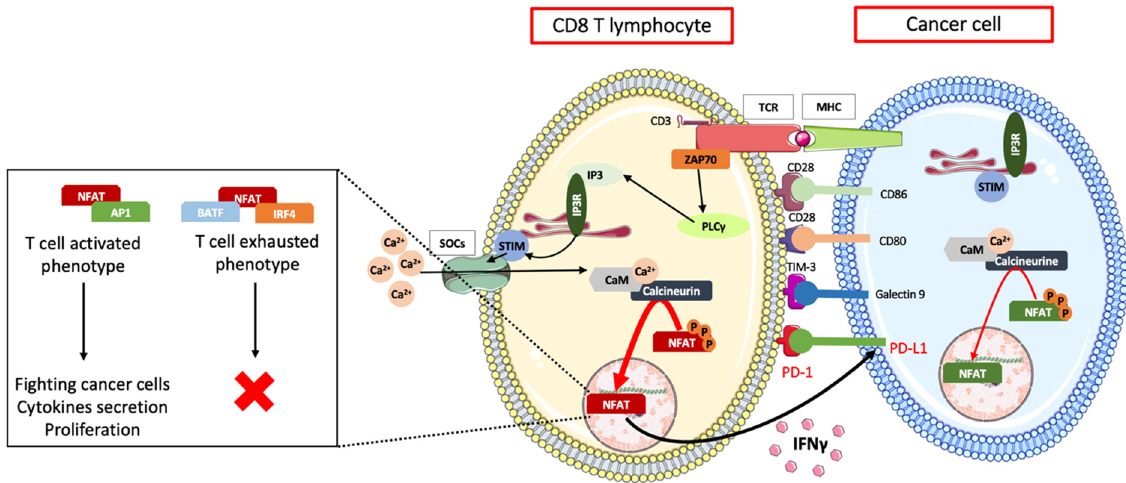
Figure 5. Cancer cell immune escape. The binding of the target cell’s MHC or antigen to the T lymphocyte TCR complex induces the release of ER calcium stores, leading to Stim1 oligomerization and allowing calcium entry through plasma membrane CRAC channels. Capacitive Ca 2+ entry induces the formation of the Ca 2+ –CaM–calcineurin complex, which in turn dephosphorylates the transcription factor NFAT, which, within minutes, translocates to the nucleus. When activated alone or with the other transcription factor AP1, NFAT allows T lymphocyte activation, and when paired with BATF or IRF4, NFAT can induce an exhausted phenotype. When bound to regulatory sequences, NFAT can modulate PD-1 expression and IFN γ cytokine secretion. When the link between PD-1 expressed by T lymphocytes and its ligand PD-L1 expressed by cancer cells is established, PD-1/PD-L1 signaling contributes to the modulation of effector functions of cytotoxic CD8 T cells. Cancer cells can also express other regulatory ligands, such as CD80/CD86 or Galectin-9, to provide a negative regulatory signal to T lymphocytes expressing their respective receptors CTLA-4 and TIM-3, resulting in T cell exhaustion. IFN γ secreted by T lymphocytes can bind to its receptor expressed by tumor cells and can thus activate the Ca 2+ /CaM/calcineurin pathway through the production of IP3, leading to the activation of NFAT, which can in turn activate the PD-L1 gene, inducing the inhibition of T cells presenting the surface molecule PD-1 and therefore preventing them from proliferating and secreting cytotoxic cytokines. Additionally, calcium influx activates NFAT1, which in turn activates the IFN γ gene promoter, inducing IFN γ production and thus regulating cytotoxic lysis and CSC survival.